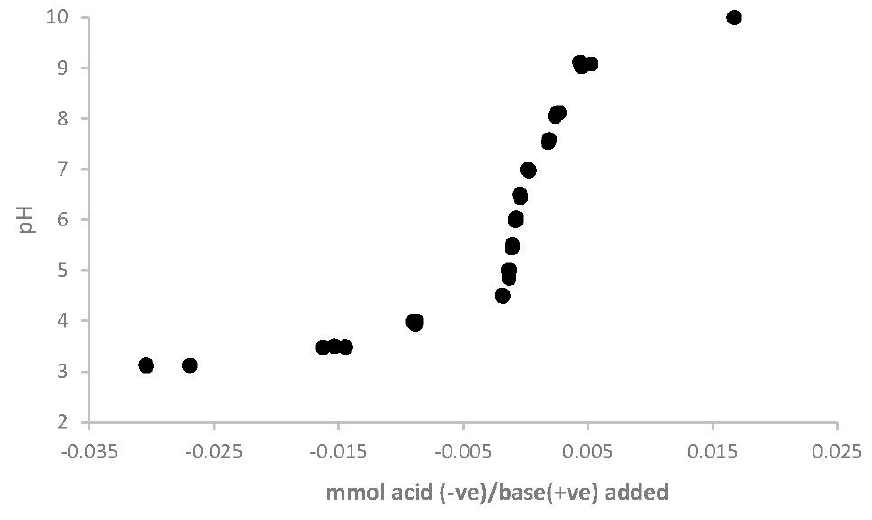
Figure 1. Effect of addition of acid( − ve)/base(+ve) to 1% ( w / v ) mallee biochar on